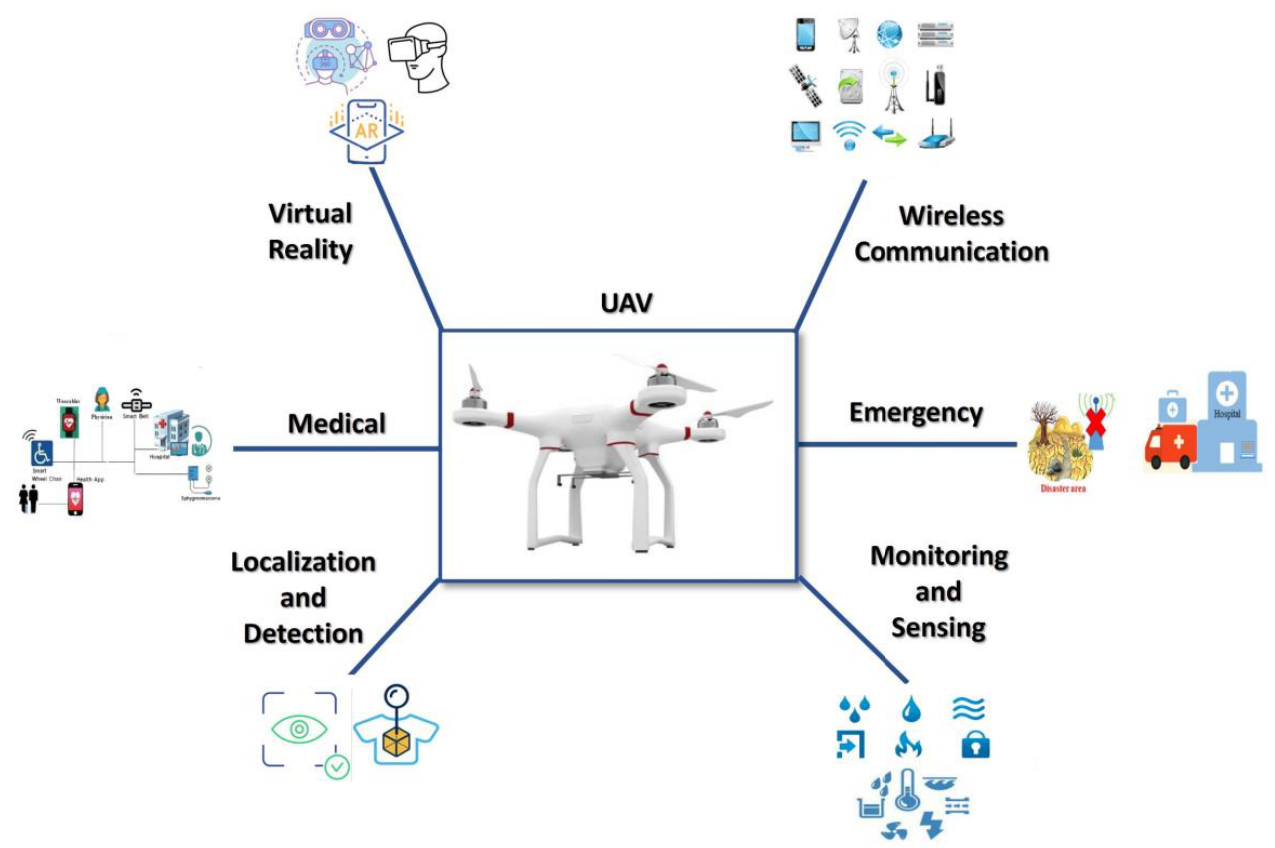
Figure 1. Representative examples of IoE-enabled UAV applications.